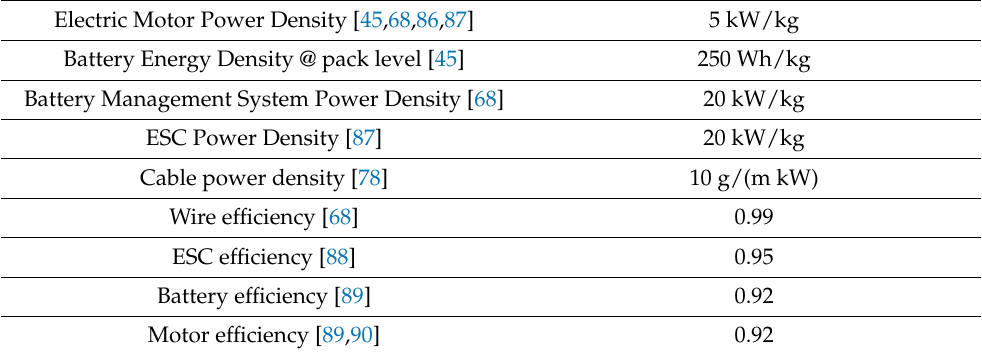
Table 10. Current technological parameters for electric machines and components, and batteries.